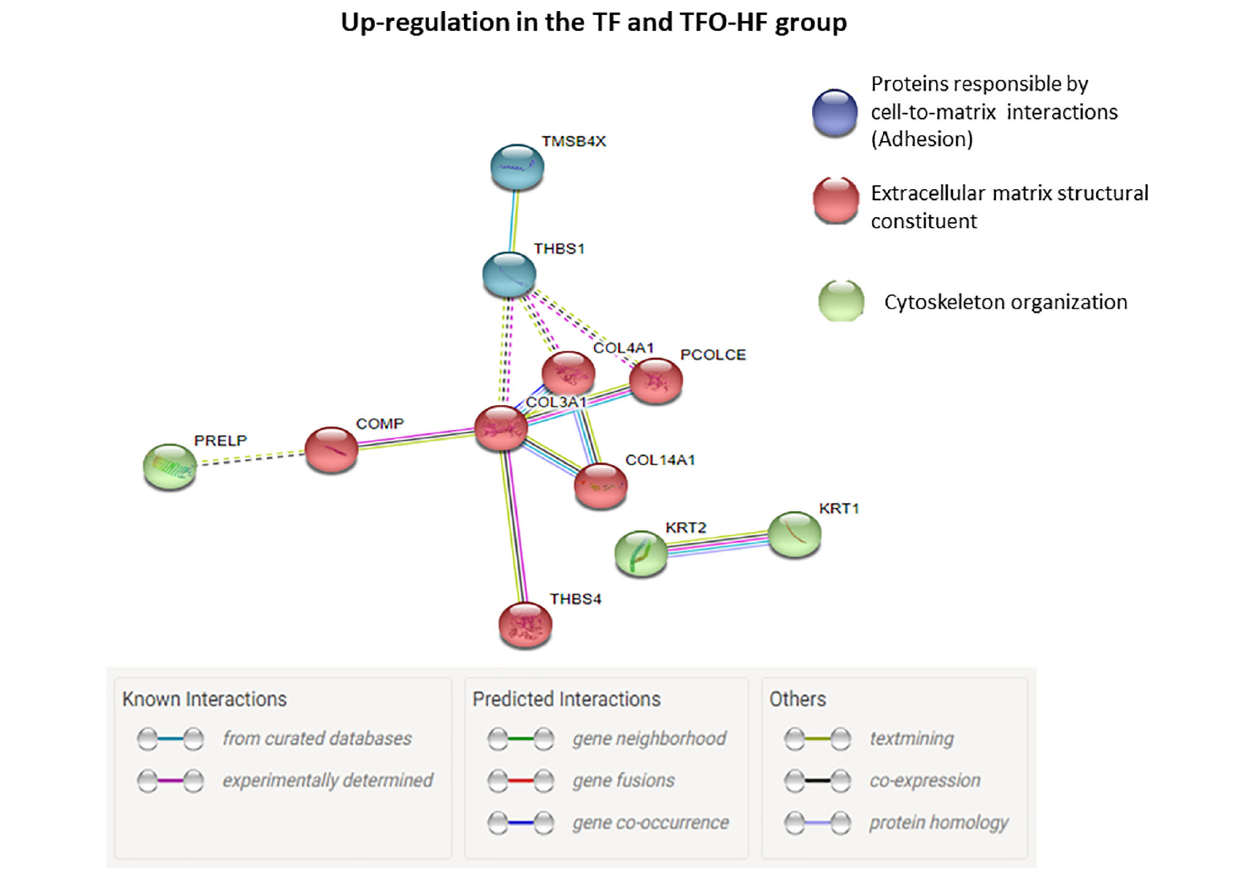
FIGURE 8 | Proteins involved in the same interaction network regarding TF and TFO-HF group. Protein-protein interaction analysis based on STRING network analysis with an interaction confidence score of 0.4. TF, trained fathers; TFO-HF, offspring from trained fathers exposed to a high-fat diet. Blue highlighted nodes are proteins responsible by cell-to-matrix interactions. Red highlighted nodes are extracellular matrix structural constituent. Green highlighted nodes are Proteins responsible by cytoskeleton organization. Upregulated proteins are grouped according to their biologic process as noted in Gen Ontology